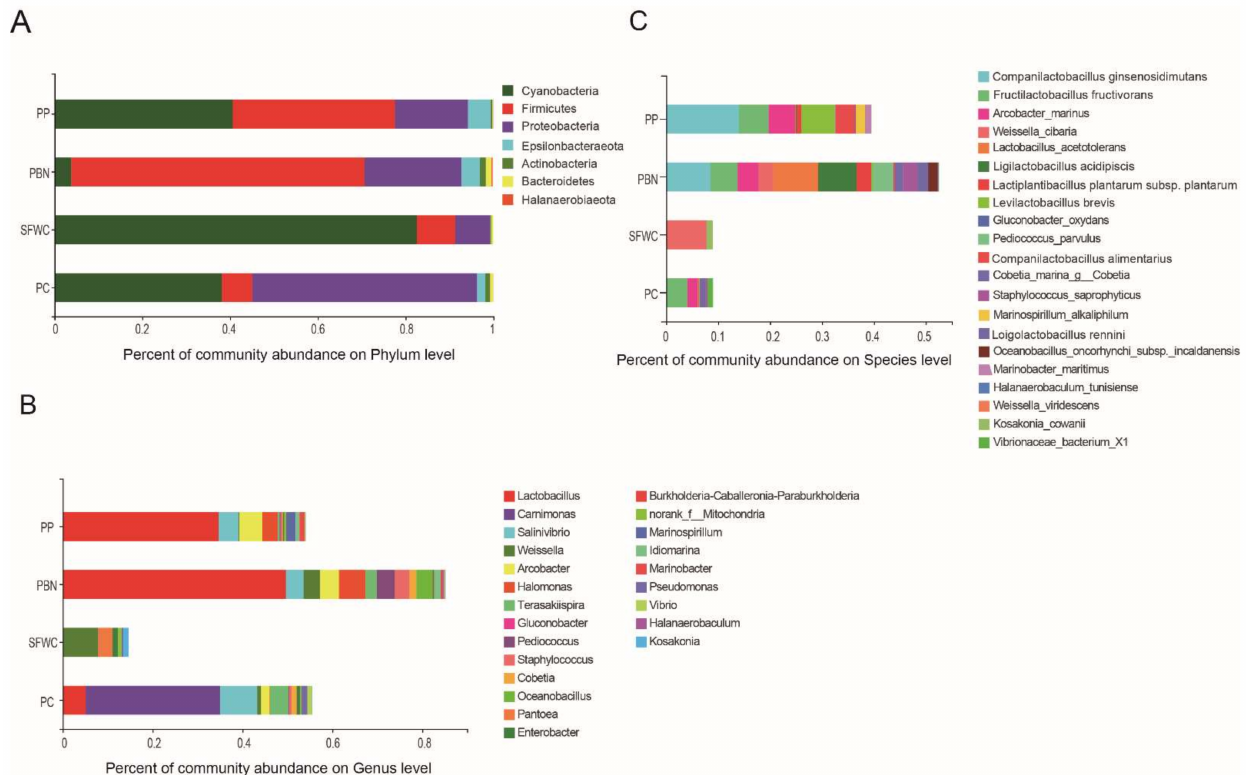
Figure 4. Composition of bacterial communities in four traditional fermented vegetables samples at the phylum ( A ), genus ( B ), species ( C ) level. Phyla, genera with proportions amounting to less than 1%, and unclassified species are not